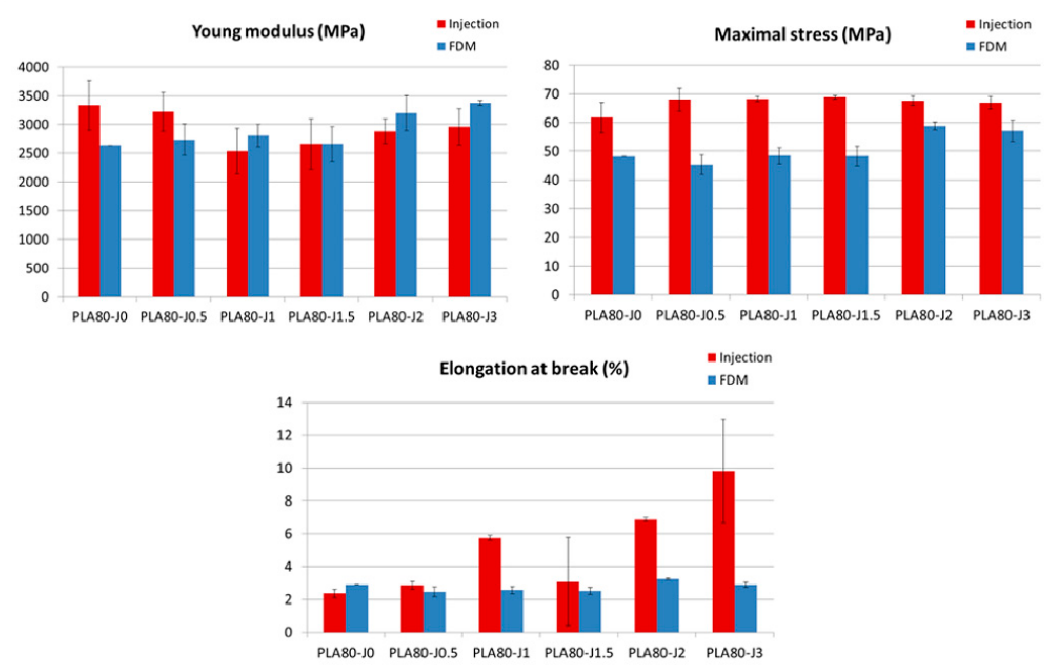
Figure 10. Injected versus FDM printed samples mechanical properties.